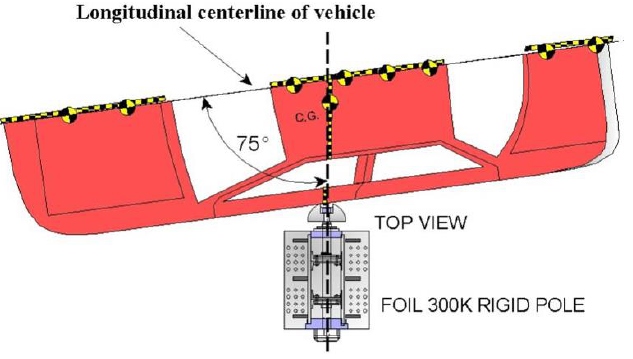
Figure 3. Pole barrier set position in impact test [9]. Available online: https://one.nhtsa.gov/staticfiles/nvs/pdf/TP214P-01_APP_B_CHECKSHEETS.pdf (accessed on 25 October 2021).